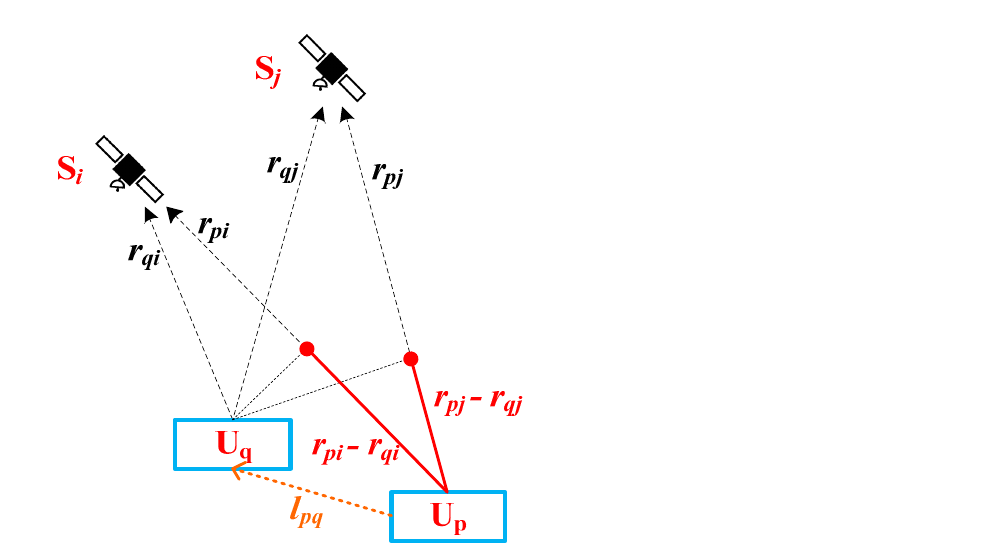
Figure 2. The double differenced Global Navigation Satellite System (GNSS) pseudorange obser- vations.